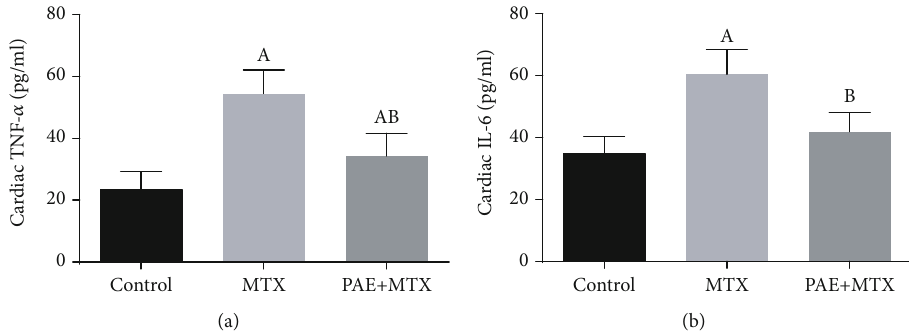
Figure 4: E ff ect of paeonol (PAE) on cardiac tumor necrosis factor- (TNF-) α (a) and interleukin- (IL-) 6 (b) levels in methotrexate- (MTX-) induced cardiac toxicity in rats. Values represent means ± SEM . “ A ” means signi fi cant di ff erence compared to the control group and “ B ” means signi fi cant di ff erence compared to the MTX-treated group, at p < 0 : 05